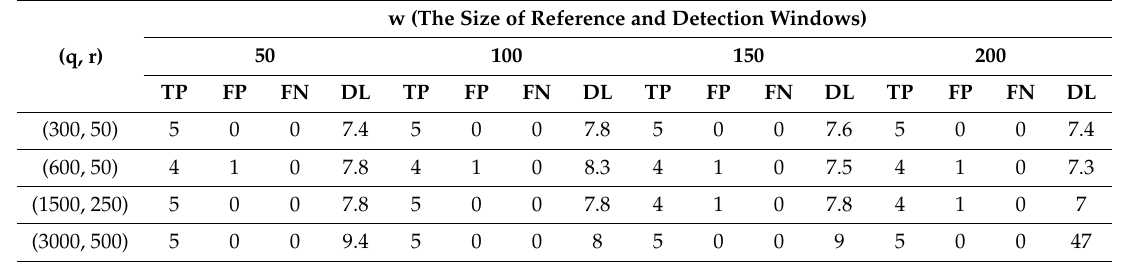
Table 4. PD detection performance for LEMKE PD data (q: the number of phase windows accumulated in a single cycle, r: the number of forward-moving phase